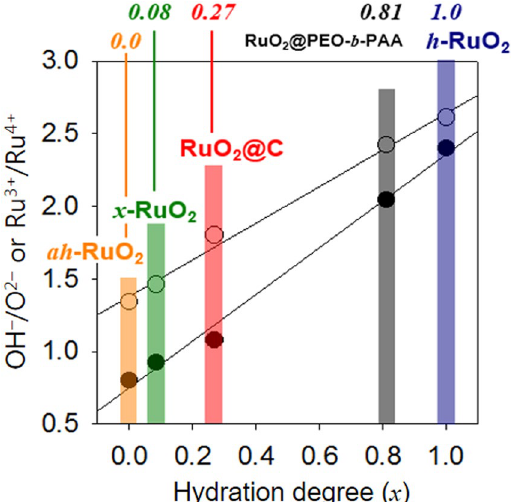
Figure 2. Hydration degree ( x ). The x values of ah -RuO 2 and h -RuO 2 were assumed to be 0.0 and 1.0, respectively. The OH − to O 2 − or Ru 3 + to Ru 4 + peak area ratios were used as a measure of the hydration degree. The x values of other RuO 2 samples were estimated from the ratios obtained by interpolating two pre-fixed points of the XPS peak ratio versus x